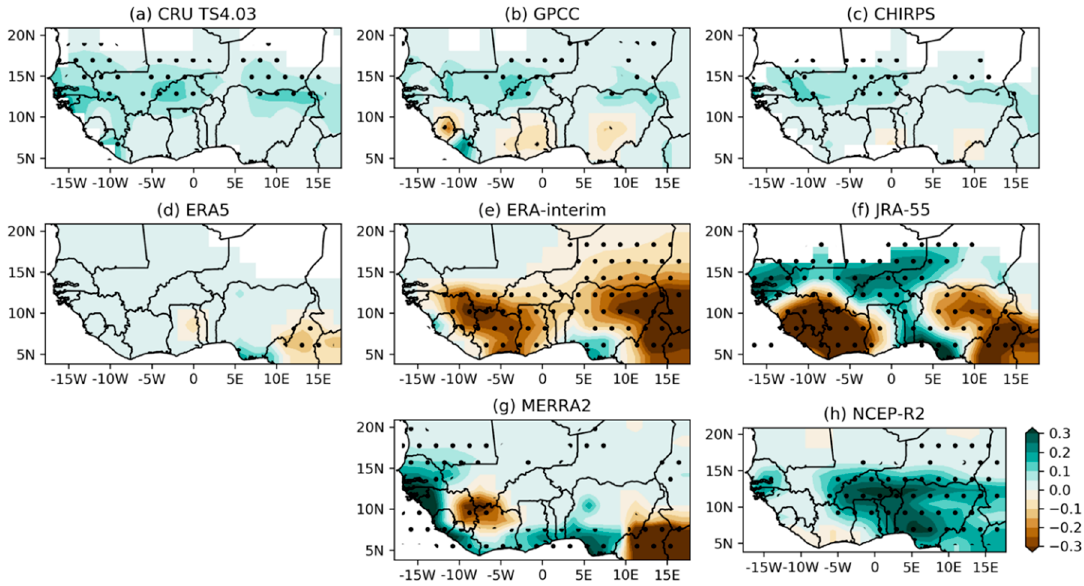
Figure 7. Spatial patterns of the JJAS precipitation linear trend for 1981–2016 (mm per day per decade) from observations ( a – c ) and five reanalyses ( d – h ). Stippling denotes statistically significant trends at the 5% significance level.